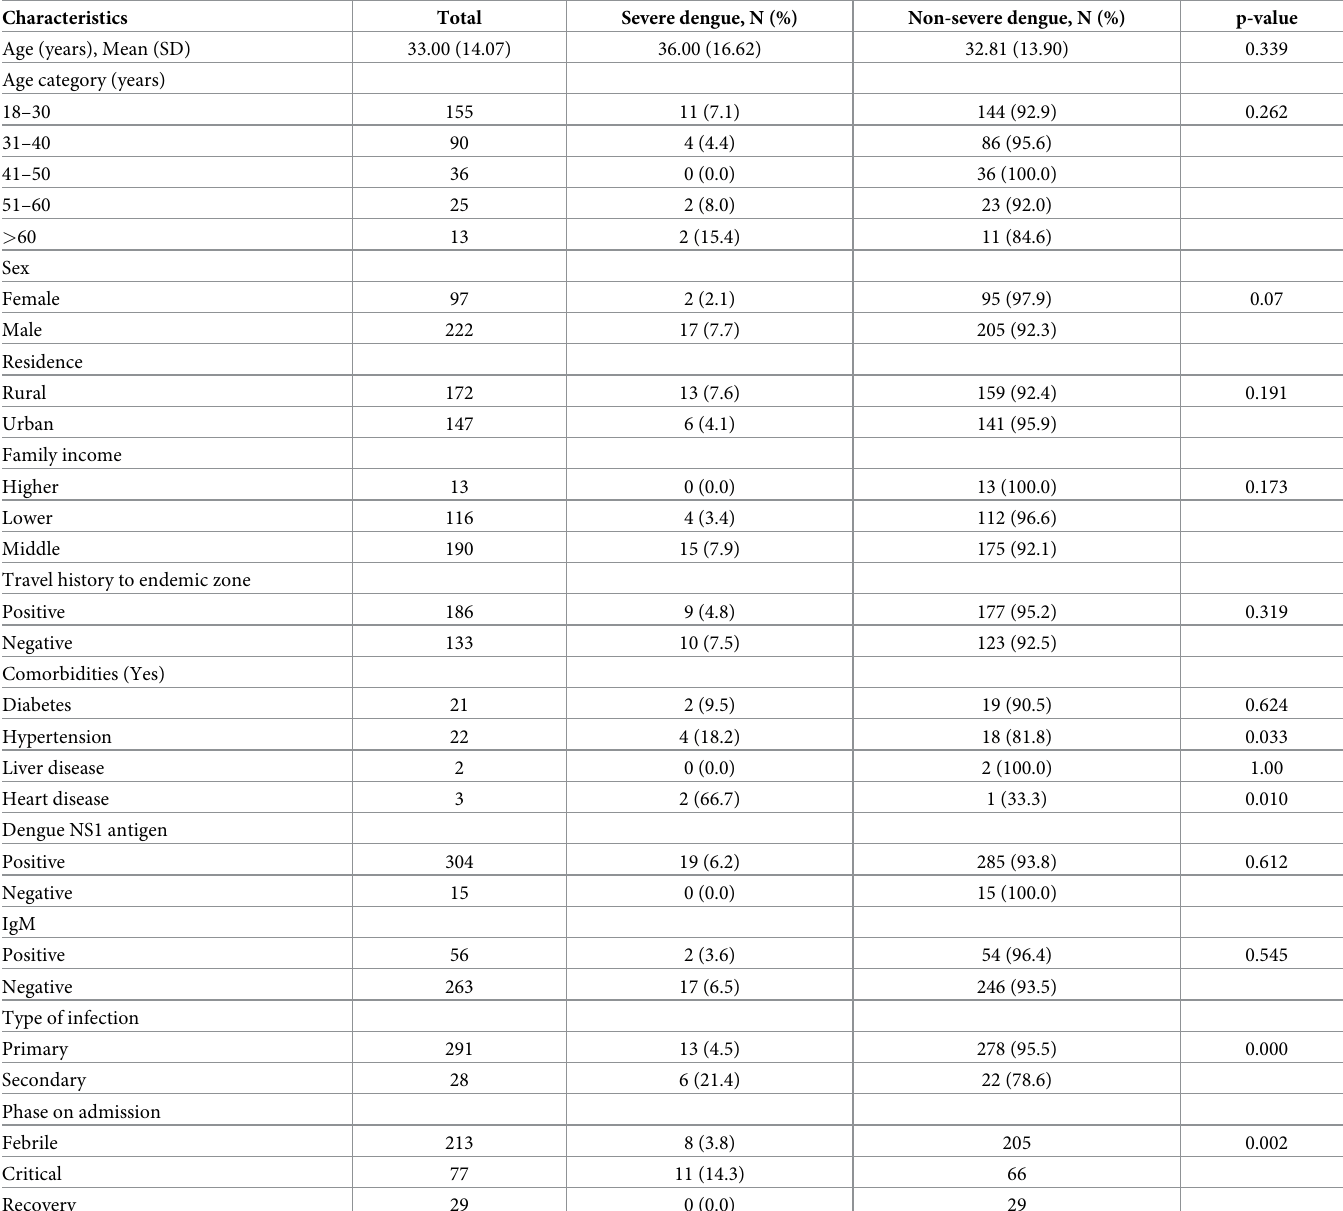
Table 1. Socio-demographic and diagnostic characters of dengue case.